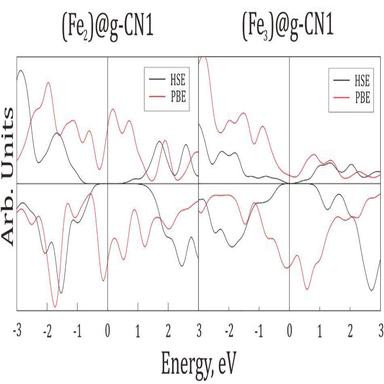
The PBE and HSE density of states of (Fe2)@g-CN1 (left) and (Fe3)@g-CN1 (right). The HSE DOSes are presented as solid black lines, PBE DOSes are presented as solid red lines. Spin-up densities are depicted with positive intensities and spin-down densities are depicted with negative intensities.